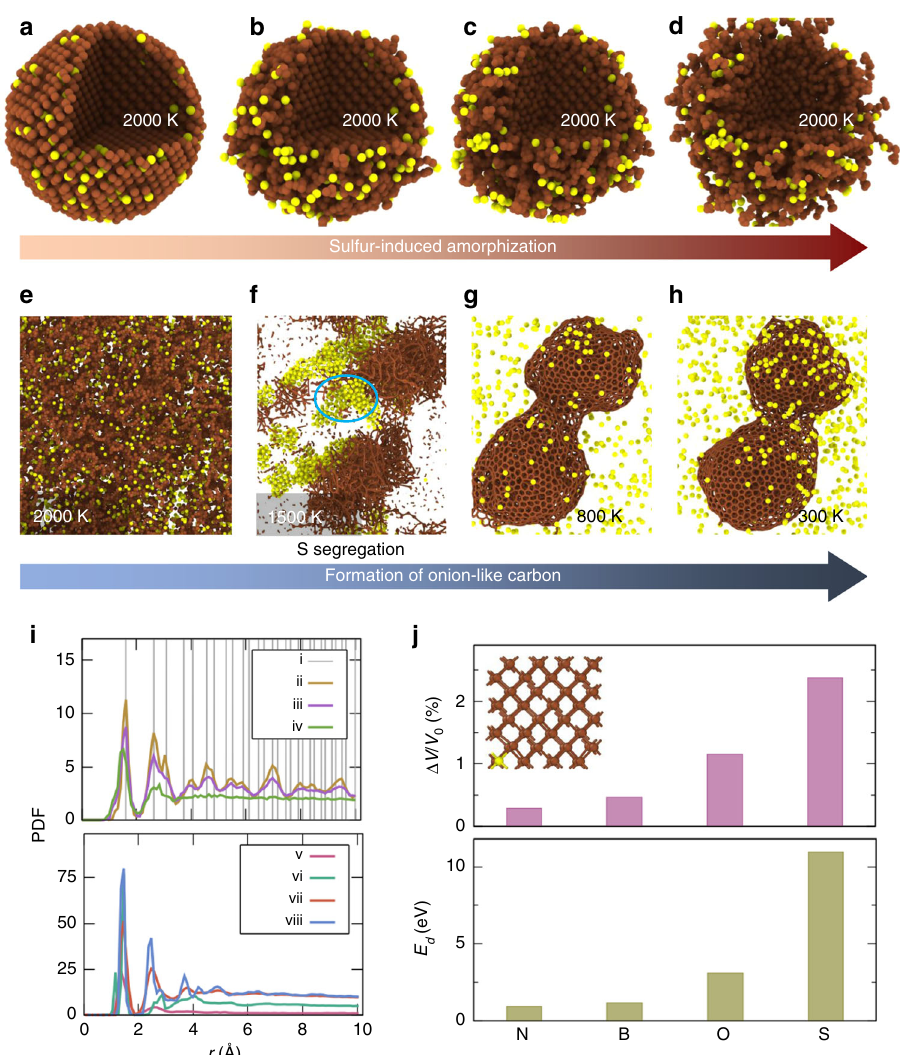
Fig. 4 Atomistic simulations of the tribochemical mechanism leading to reduction in friction. a – d Atomic snapshots from RMD simulations at selected times during the sulfur-induced amorphization of diamond nanoparticle. e – h Atomic snapshots from RMD simulations at selected times during the formation of OLC structures from amorphous carbon matrix containing uniformly dispersed S atoms (15% S concentration). i pair distribution functions of C-C for each snapshot shown in a , b . j Volumetric strains in the diamond lattice (Top) induced by substituting a C atom with different impurity atoms, and the corresponding defect energies E d (Bottom) obtained from DFT calculations. In panels a – d , and e – h , the temperatures corresponding to the atomic snapshots are provided. In panel j , Δ V refers to change in the volume of diamond lattice owing to introduction of a substitutional defect, and V 0 refers to the volume of diamond lattice at